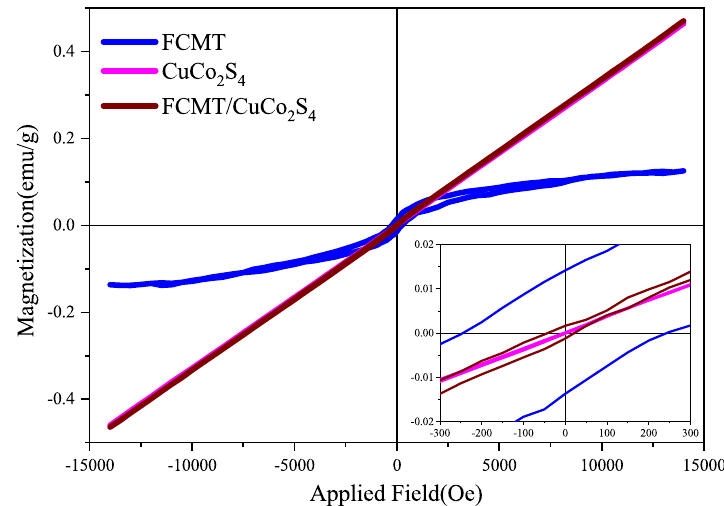
Figure 6. M–H loops for FCMT, CuCo 2 S 4 , and FCMT/CuCo 2 S 4 structures.